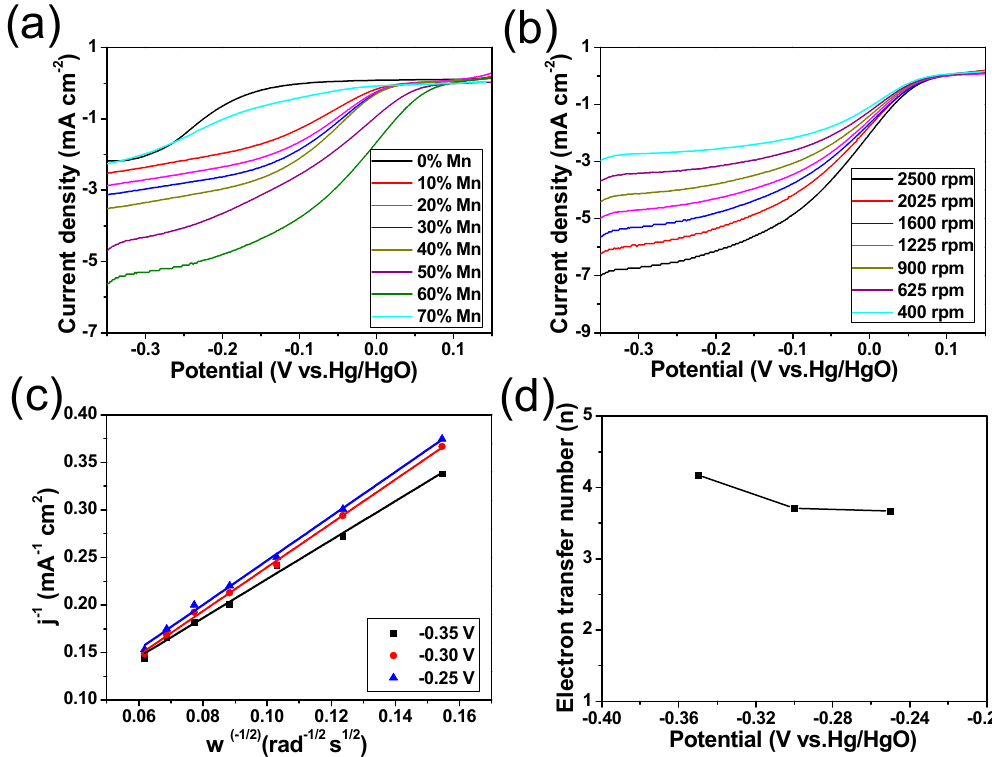
Figure 8. In 0.1 mol L − 1 KOH solution, ( a ) linear sweep voltammetry (LSV) curves of Ag 4 Bi 2 O 5 with different ratios of manganese dioxides (0% Mn to 70% Mn) with O 2 saturation at a potential scanning rate of 5 mV s − 1 and a rotation speed of 1600 rpm, ( b ) LSV curves of Ag 4 Bi 2 O 5 with 60% Mn at different rotation speeds (400–2500 rpm) at scanning rate of 5 mV s − 1 , ( c ) Koutecky-Levich curves of Ag 4 Bi 2 O 5 with 60% Mn at different potentials, ( d ) Number of transferring electrons at the corresponding potentials.